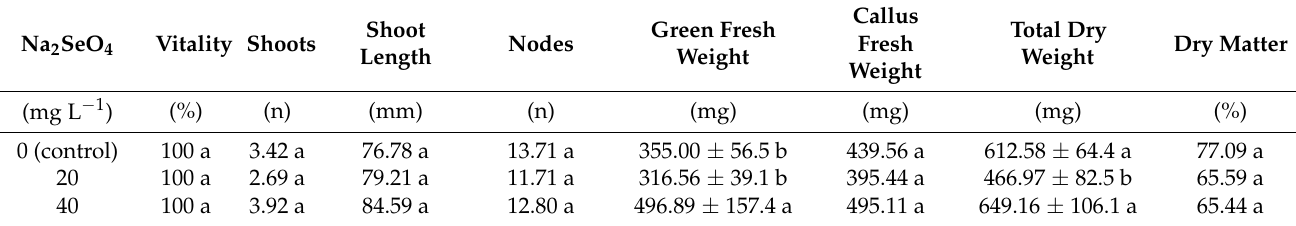
Table 4. Average values of the three subcultures for proliferated explants of the ‘Canino’ cv.